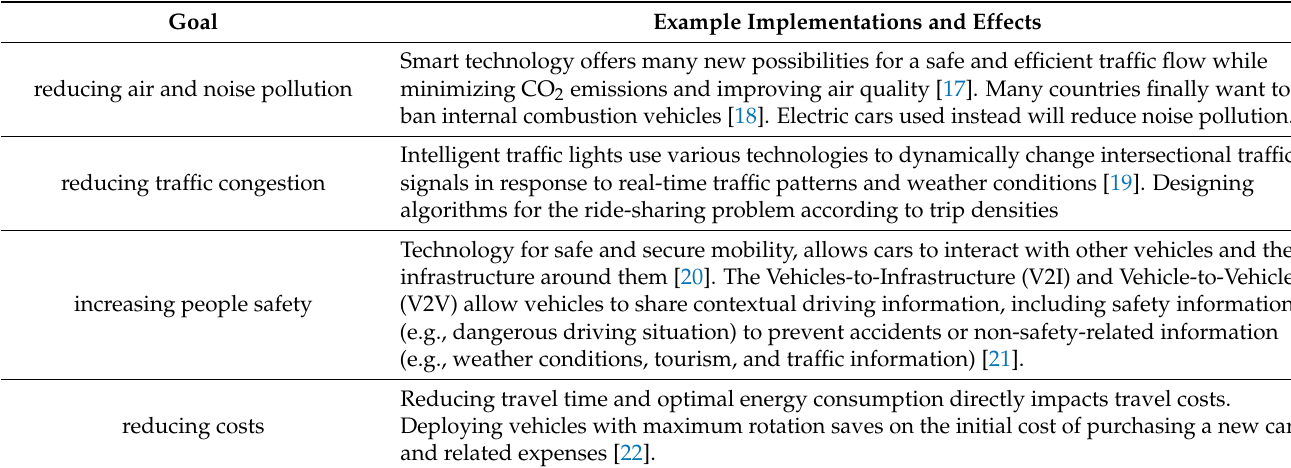
Table 1. Smart Mobility goals and